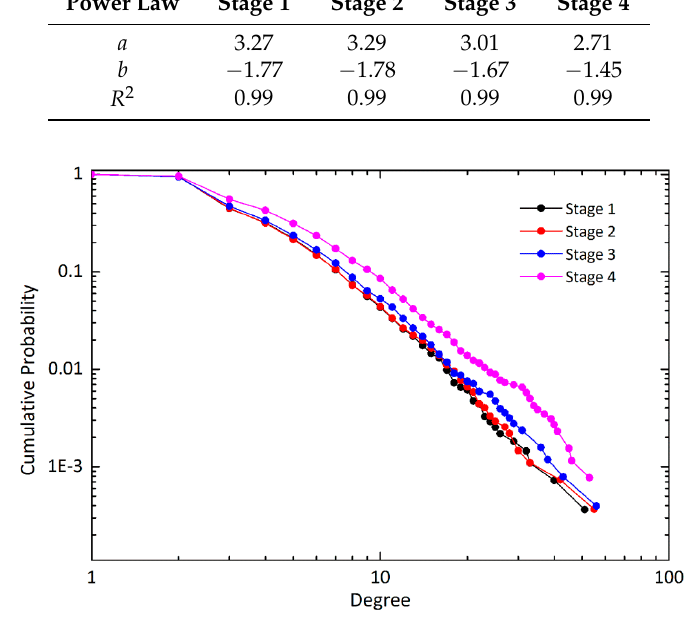
Figure 4. Cumulative probability of degree distribution in different stages.